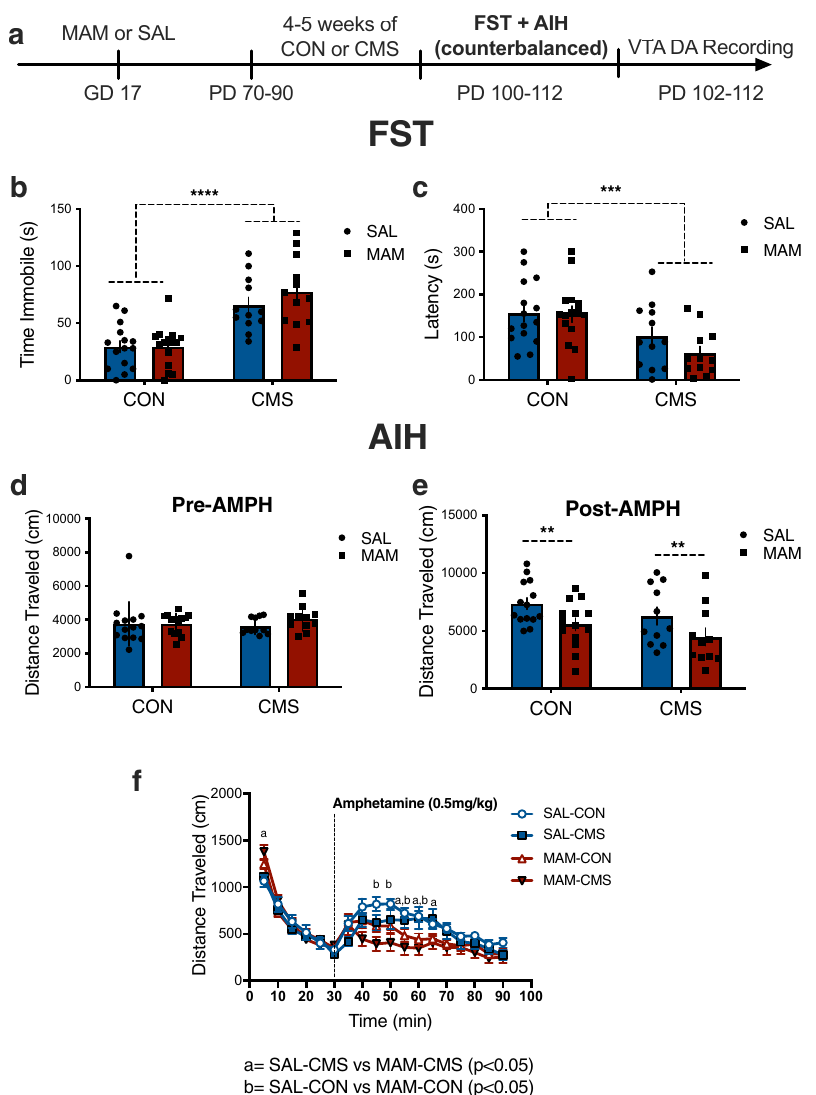
Fig. 3 Behavioural effects of prenatal MAM treatment and adult CMS exposure on forced swim (FST) and amphetamine-induced hyperlocomotion (AIH). a Timeline and experimental design. SAL and MAM animals exposed to adult CMS were tested in the FST and for AIH in a counterbalanced order (~1 week in between tests) and exhibited b increased immobility duration in the FST ( p < 0.0001) and c reduced latency to immobility ( p < 0.001) compared to SAL-CON and MAM-CON animals (main effect of CMS: p < 0.05, n = 12 – 15 per group). d No effect of MAM treatment ( p = 0.38) or adult CMS exposure ( p = 0.79) was found for total distance traveled at baseline (30 min). e Post-FST, a main effect of MAM treatment was found on total distance traveled over 60 min following amphetamine (AMPH) injection (one-way ANOVA: p < 0.01, n = 11 – 14 per group). Both MAM groups (i.e. MAM-CON, MAM-CMS) exhibited blunted locomotor responses to AMPH compared to SAL groups. f Speci fi cally, MAM-CON rats exhibited blunted locomotor response to AMPH compared to SAL-CON rats at 15, 20, 25 and 30 min post-AMPH injection; MAM-CMS rats exhibited blunted locomotor response to AMPH compared with SAL-CMS rats at 25, 30 and 35 min post- injection. Blue bars and circles represent SAL animals; red bars and squares represent MAM animals. CON groups are plotted on the left and CMS groups are plotted on the right. ** p < 0.01, *** p < 0.001, **** p < MAM-CON: 3.64 ± 2.37 Hz; SAL-CMS: 4.23 ± 2.01 Hz; MAM-CMS: At baseline (i.e. no FST), there were no effects of MAM (two-way 3.75 ± 1.67 Hz; Fig. 4i). ANOVA; F 1,162 = 1.031; p = 0.31) or CMS (two-way ANOVA; F 1,162 = At baseline (i.e. no FST), there were no effects of MAM (two-way 0.173; p = 0.68) on fi ring rate (SAL-CON: 3.91 ± 2.17 Hz; MAM-CON: ANOVA; F 1,162 = 0.80; p = 0.37) or CMS (two-way ANOVA; F 1,162 = 3.93 ± 1.99 Hz; SAL-CMS: 3.70 ± 2.84 Hz; MAM-CMS: 4.46 ± 2.38 Hz; Fig. 4g). Post-FST and AIH, no effects of MAM (two-way ANOVA; 1.71; p = 0.19) on percentage of spikes fi ring in bursts (SAL-CON: F 1,157 = 0.13; p = 0.71) or CMS (two-way ANOVA; F 1,157 = 0.63; p = 26.66 ± 27.63%; MAM-CON: 19.96 ± 23.58%; SAL-CMS: 29.98 ± 31.11%; MAM-CMS: 28.54 ± 28.67%; Fig. 4j). Post-FST and AIH, no 0.43) were found for fi ring rate (SAL-CON: 3.71 ± 1.79 Hz; MAM- effects of MAM (two-way ANOVA; F 1,157 = 0.24; p = 0.62) or CMS CON: 4.47 ± 1.85 Hz; SAL-CMS: 4.84 ± 2.30 Hz; MAM-CMS: 3.85 ± 1.93 Hz; Fig. 4h). Post-FST only, no effects of MAM (two-way (two-way ANOVA; F 1,157 = 0.0043; p = 0.95) were found for ANOVA; F 1,218 = 2.24; p = 0.14) or CMS (two-way ANOVA; F 1,218 = percentage of spikes fi ring in bursts (SAL-CON: 29.33 ± 24.28%; 0.30; p = 0.58) were found for fi ring rate (SAL-CON: 4.03 ± 1.97 Hz; MAM-CON: 34.33 ± 25.96%; SAL-CMS: 32.01 ± 28.38%; MAM-CMS: